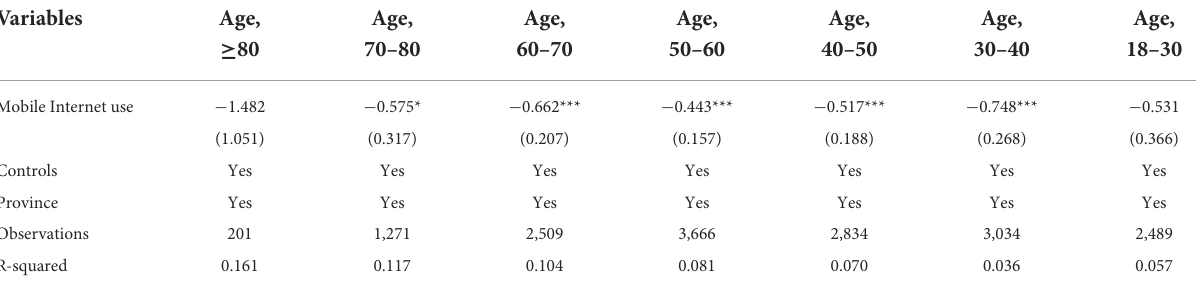
TABLE 4 Regression results by age